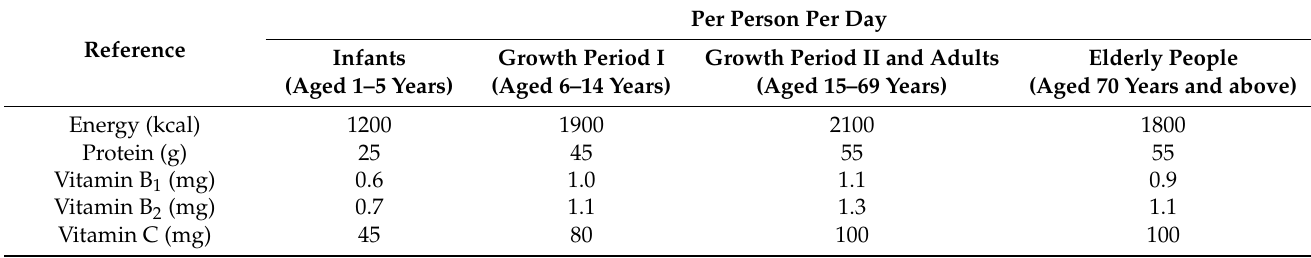
Table 10. Nutritional Reference Values for planning by age group.